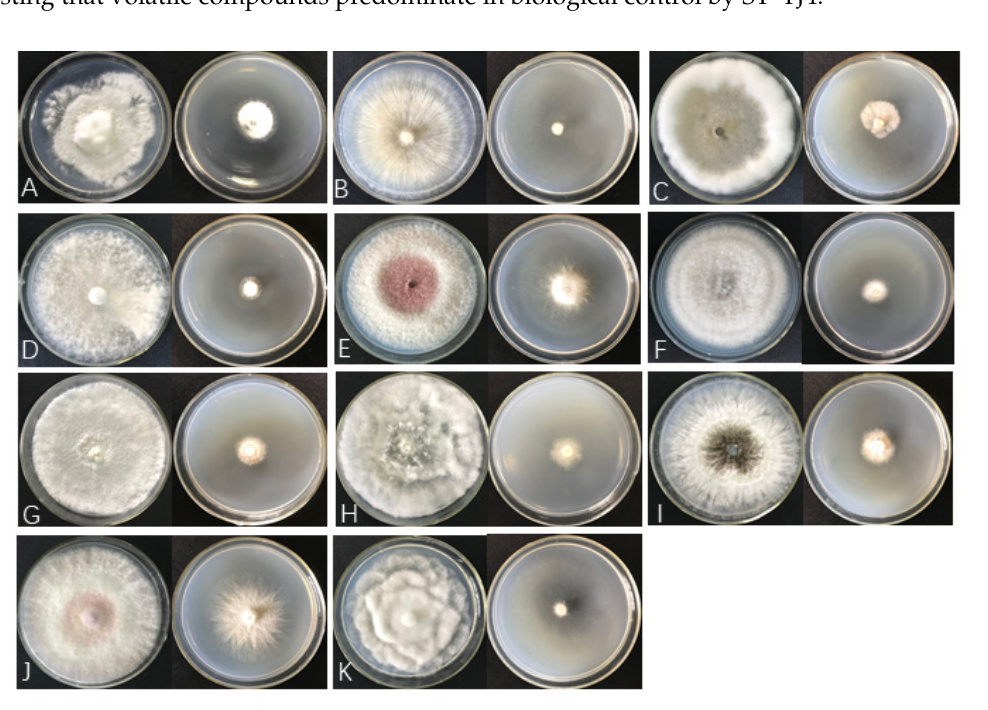
Figure 4. The antifungal spectrum of strain ST–TJ4 VOCs. Plate on the right treated with VOCs, plate on the left untreated. ( A ) Pestalotiopsis versicolor ; ( B ) Rhizoctonia solani ; ( C ) Fusicoccus aesculi ; ( D ) Cytospora chrysosperma ; ( E ) Fusarium graminearum ; ( F ) Colletotrichum tropicale ; ( G ) Phomopsis ricinella ; ( H ) Botryosphaeria berengeriana ; ( I ) Sphaeropsis sapinea ; ( J ) Fusarium oxysporum and ( K ) Phytophthora